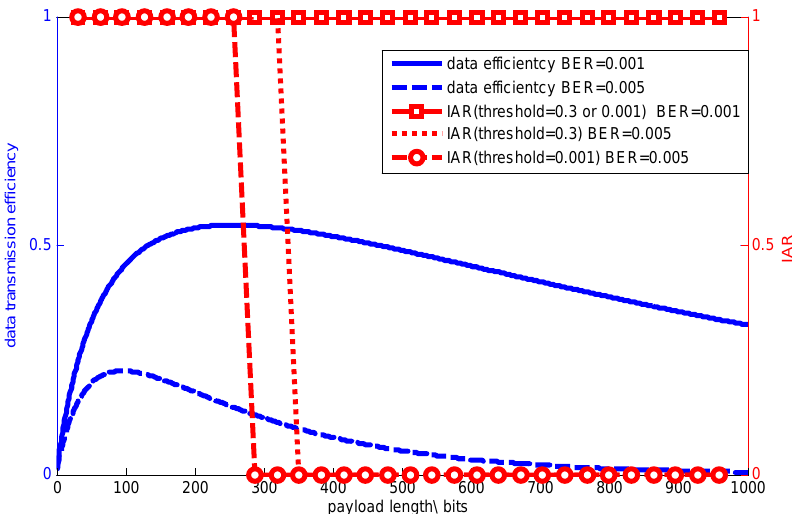
Figure 18. Comparison between data and signal transmission